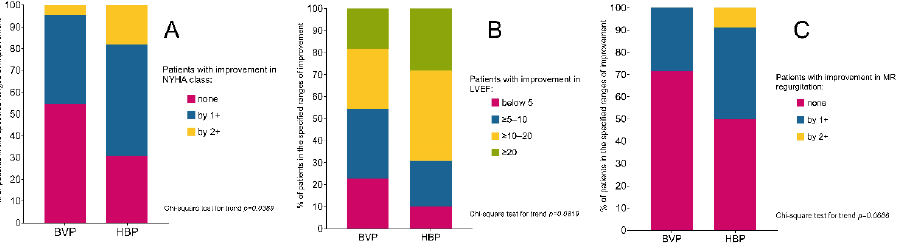
Figure 2. The response rates in the improvement of NYHA class ( A ), LVEF ( B ), and mitral regurgi- tation ( C ) after six months of FU, in specified ranges, in HBP patients compared with BVP patients. BVP — biventricular pacing, HBP — His bundle pacing, LVEF — left ventricular ejection fraction, MR – mitral regurgitation, NYHA — New York Heart Association.